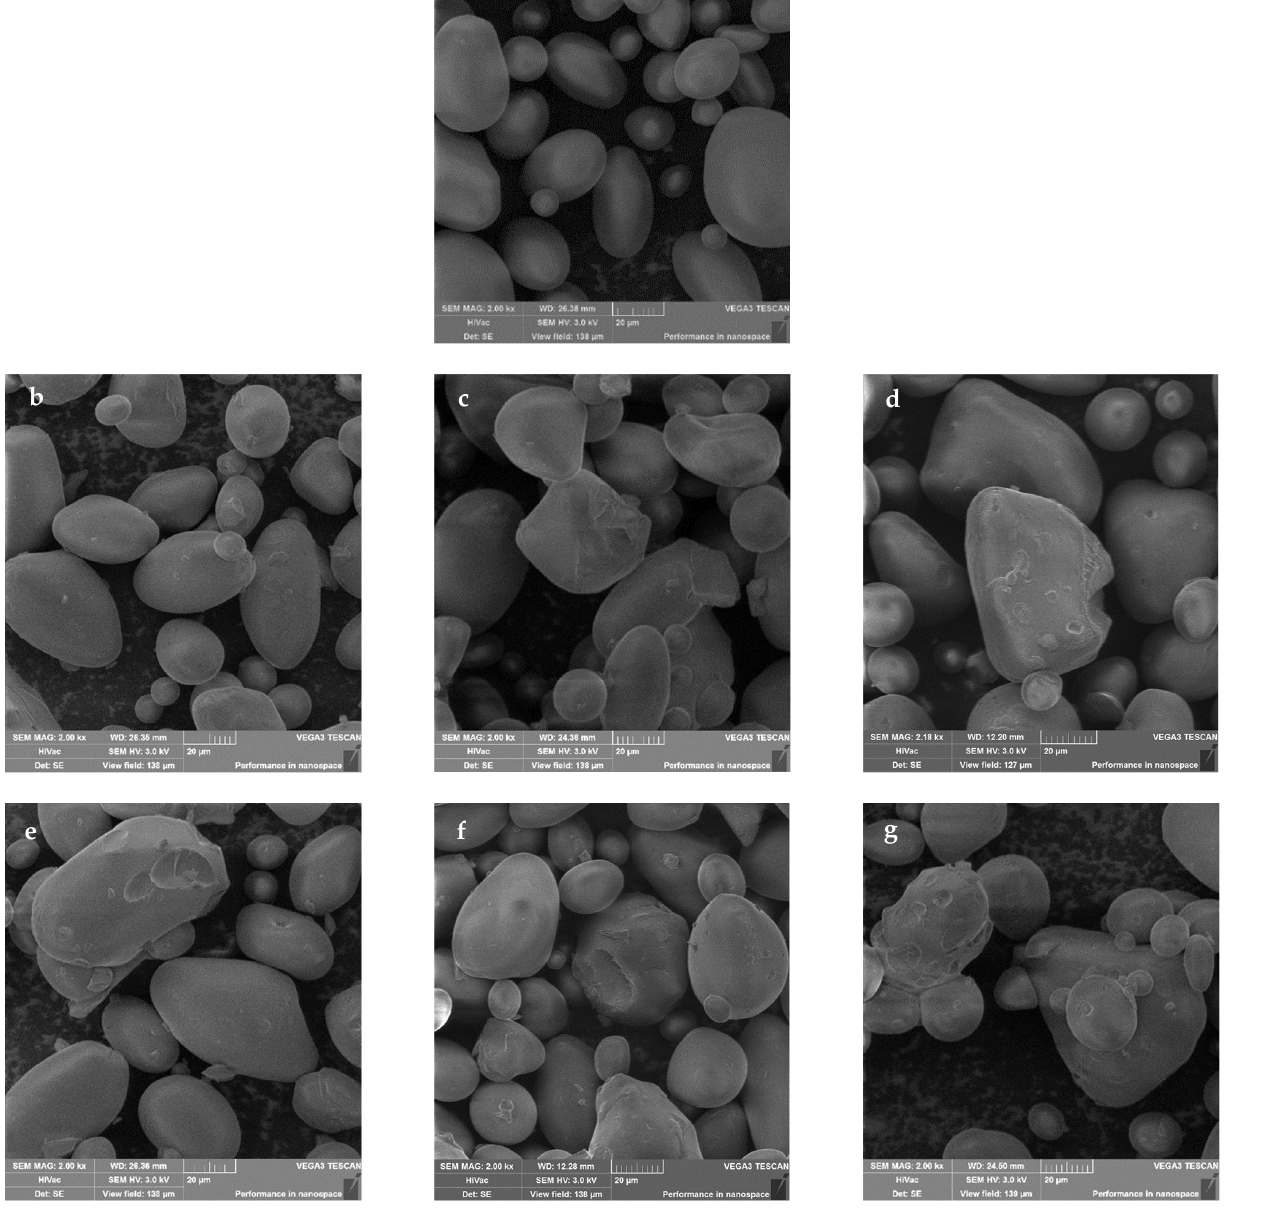
Figure 5. SEM micrographs of native potato starch ( a ) and obtained dextrins obtained by microwave-assisted heating for 15 s at 100 W ( b ), 110 W ( c ), and 120 W ( d ) and for 30 s at 100 W ( e ), 110 W ( f ), and 120 W ( g ).